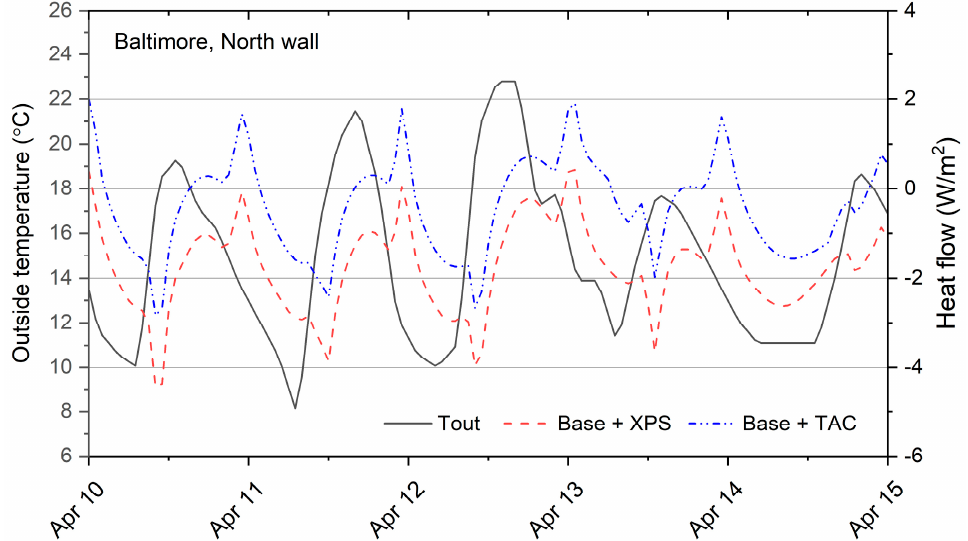
Figure 13. Outdoor temperature (left axis) and calculated heat flows (right axis) through a north-facing wall in Baltimore.